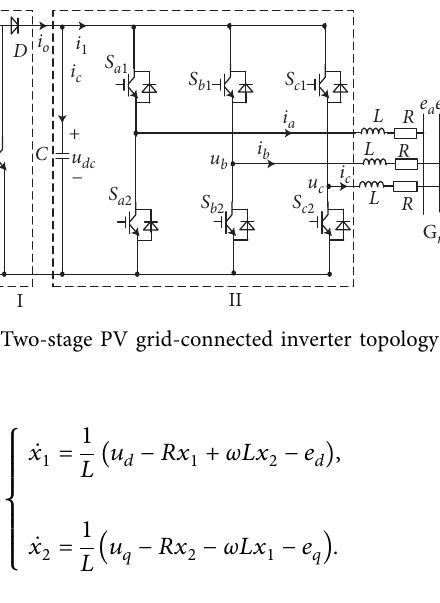
Figure 2: Block diagram of control system